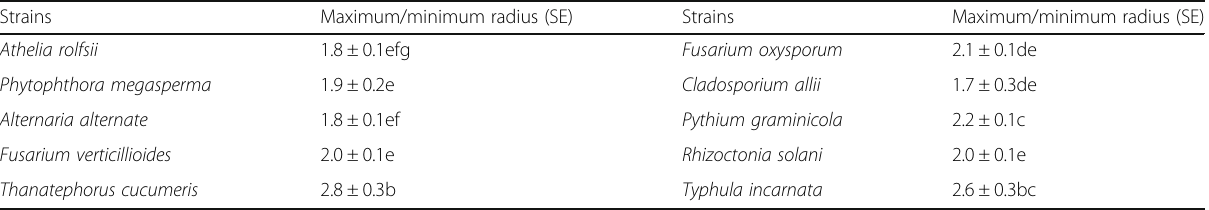
Table 1 Inhibitory spectrum of Bacillus velezensis BM21 against 10 species of pathogenic fungi Strains